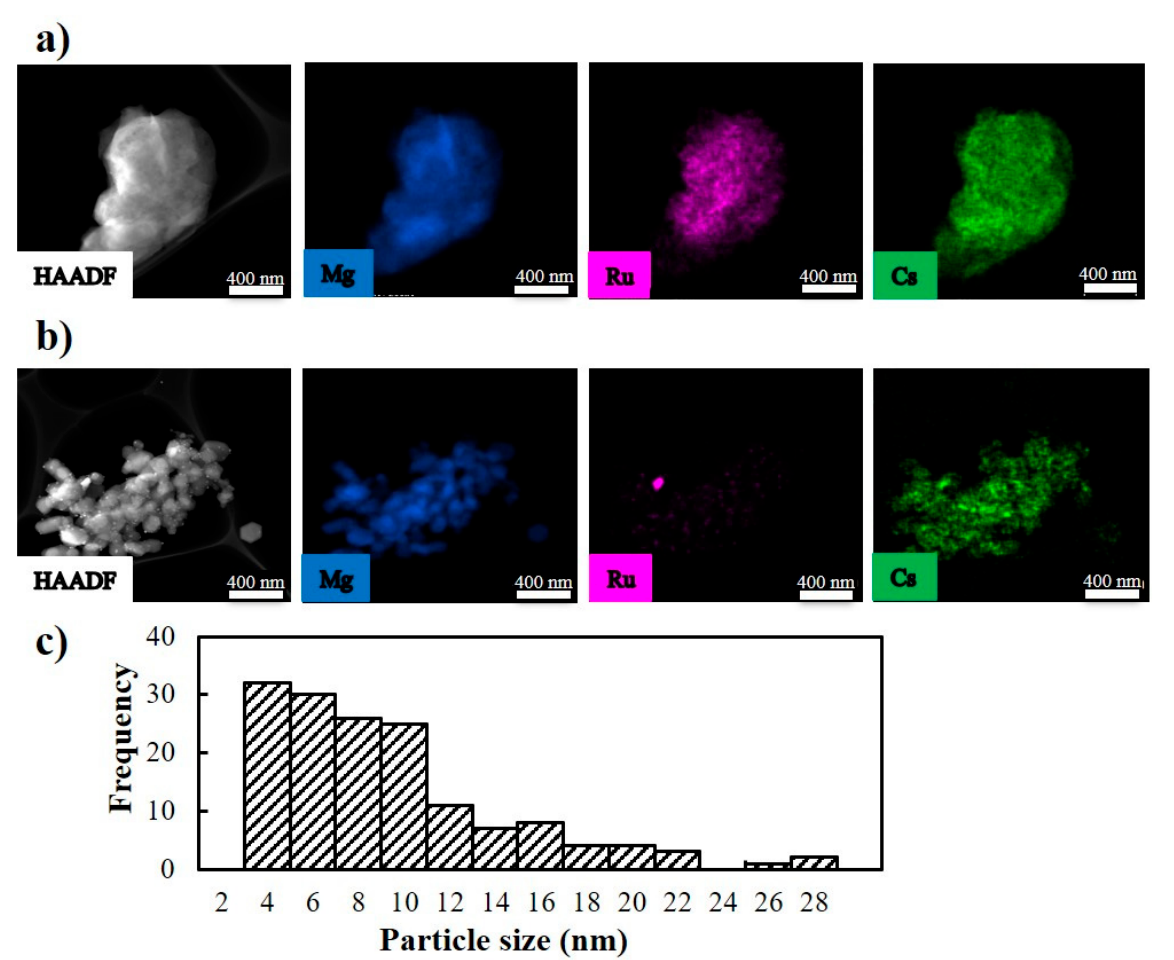
Figure 4. HAADF-STEM images with elemental mapping for Mg, Ru, and Cs: ( a ) as-synthesized catalyst, ( b ) after a time on stream of 680 h, and ( c ) histogram of the particle size distribution of Ru in the used catalyst after 680 h of time on stream.